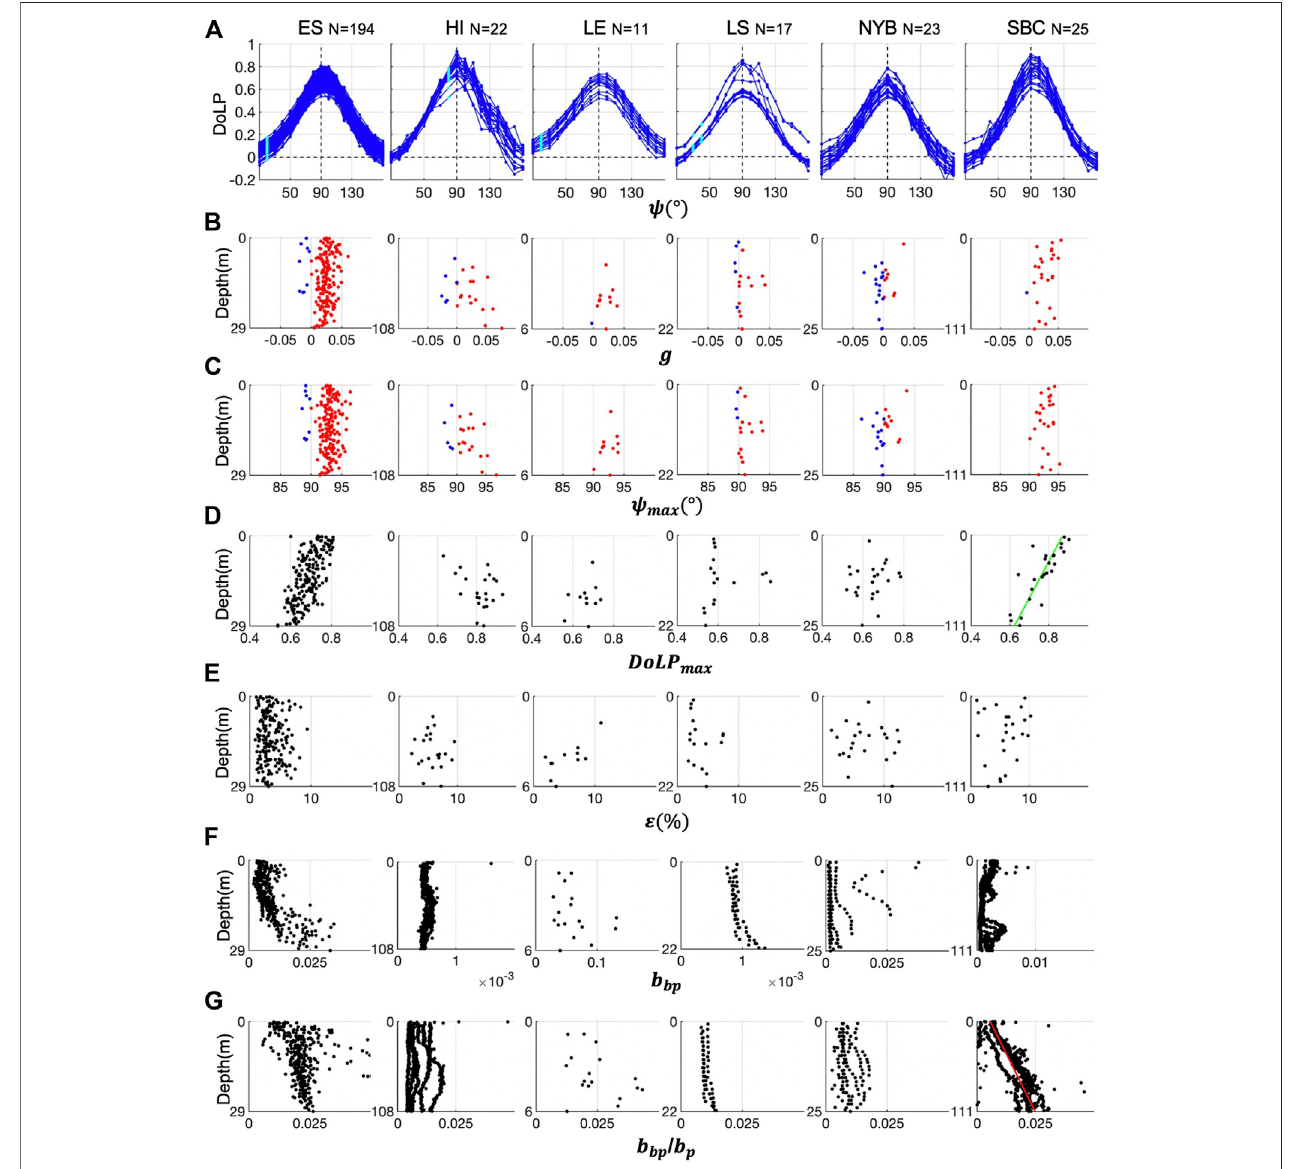
pro fi lesoftheasymmetryparameter g ofDoLPsofeach fi eldsite.Bluedotsindicatenegative g andreddotsindicatepositive g . (C) Verticalpro fi lesofthepeakangle ψ max ofDoLPs ofeach fi eld site. Bluedots correspond to ψ max < 90 ° and red dots correspond to ψ max > 90 ° . (D) Verticalpro fi les ofthepeak magnitude DoLP max ofDoLPs ofeach fi eldsite. (E) Verticalpro fi lesoftheRMSE ε ( Eq.13 )betweenthemeasuredDoLPsandtheirbest- fi tskewedRayleighDoLPs( Eq.12 )ofeach fi eldsite. (F) Vertical pro fi les of the particulate backscattering coef fi cient b bp of each fi eld site. (G) Vertical pro fi les of the particulate backscattering ratio b bp / b p of each fi eld site. Linear least squares fi ttotheverticalpro fi lesareoverlaidwheresigni fi cant(wherethecoef fi cientofdetermination R 2 > 0.5).Redlinesindicatepositivecorrelationbetweenthequantity and depth, green lines indicate negative